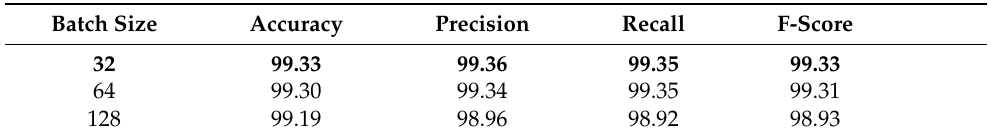
Table 4. Average recognition performance of the proposed KinectGaitNet with ReLU activation functions, Adam optimizer, and different batch sizes on the KGB dataset. The best performance is shown in bold.